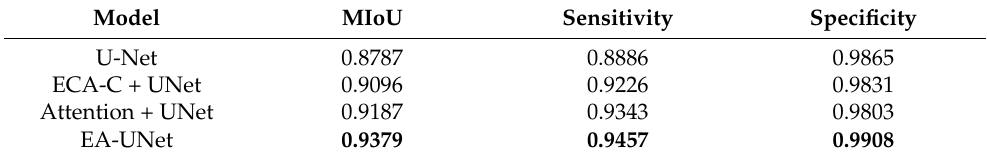
Table 1. Ablation experiments of effect of different modules on performance of U-Net